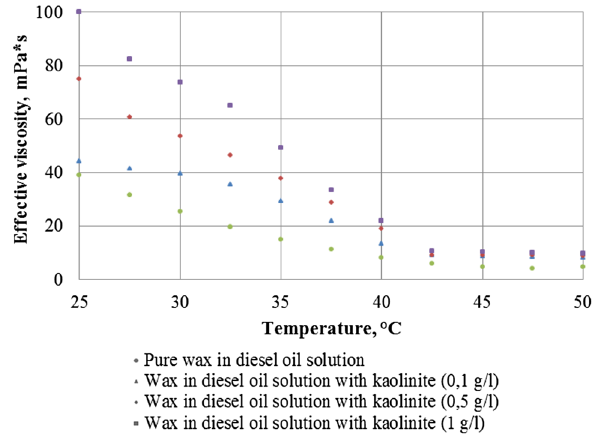
Fig. 5 Effect of temperature and kaolinite concentration on viscosity of wax-bearing solution (wax concentration of 30%wt.)